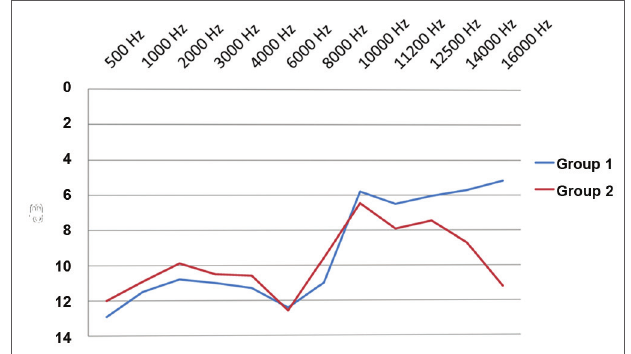
Figure 2. Mean value of auditory thresholds (dB HL x Hz) in both groups.